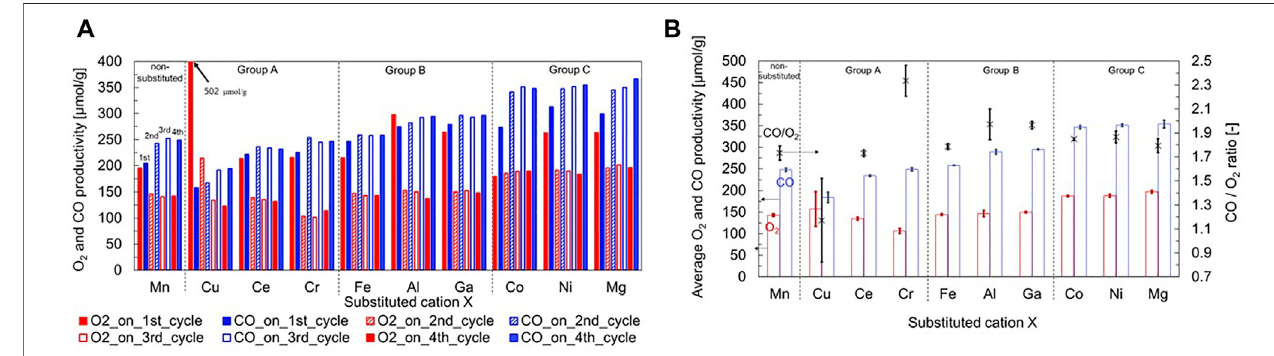
FIGURE3|(A) O 2 andCOproductivitiesofallsamplesduringthe fi rsttofourthrunsand (B) averagevaluesofO 2 andCOproductionandCO/O 2 ratiointhesecond to fourth runs of the two-step thermochemical CO 2 splitting activity